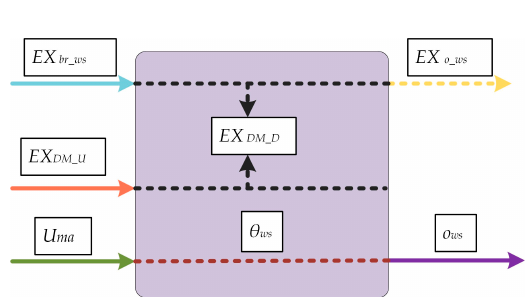
Figure A1. Process flowsheets of DM .